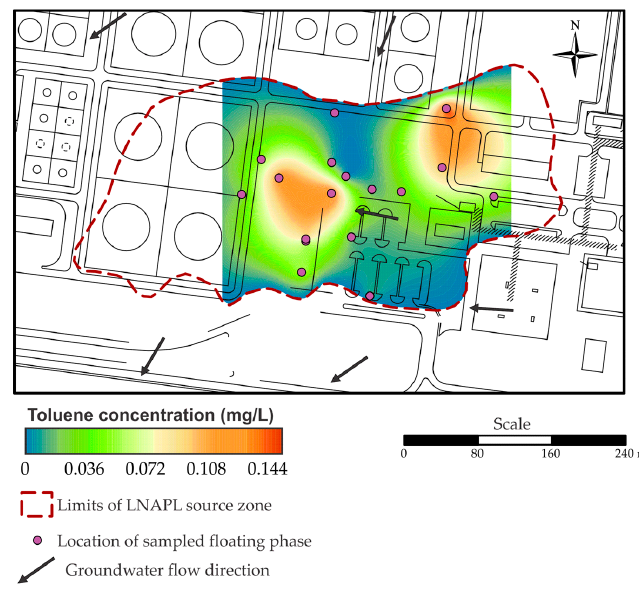
Figure 4. Toluene concentrations in the LNAPL. The map was built using the analytical results presented by Teramoto [36].